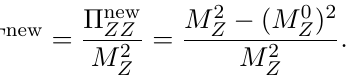
Figure 4. Comparison of the 95% CL upper bound on the observed and the expected (cid:27) ( pp Z 0 ) BR ( Z 0 ‘‘ ) obtained from the ATLAS dilepton resonance search data at the 13 TeV LHC (cid:2) ! with L = 139 fb (cid:0) 1 with the theoretical predictions of our model for z Q = We use the reference value for the U(1) z gauge coupling g z = 0 : 15. The green and yellow bands represent the 1 (cid:27) and 2 (cid:27) uncertainty regions of the expected values